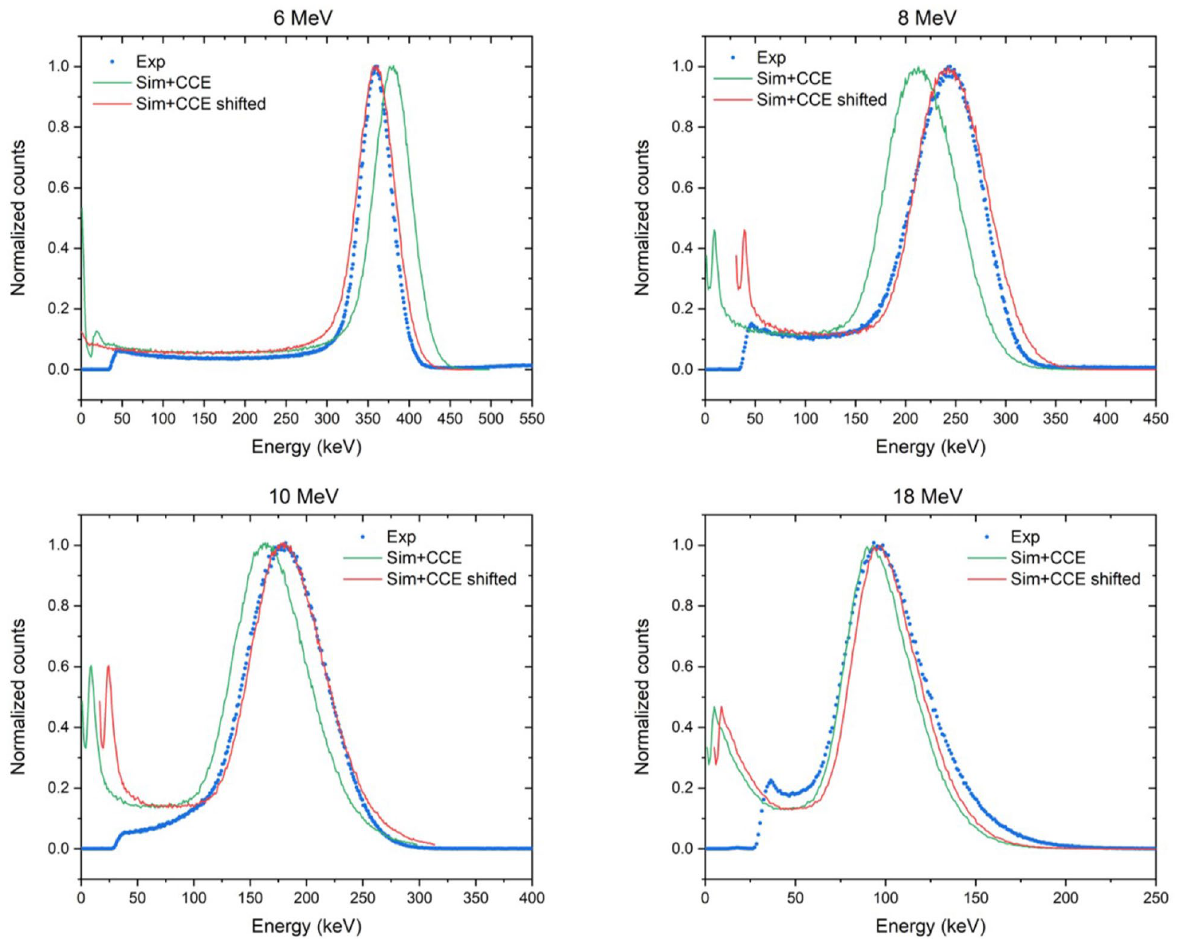
Figure 7. Experimental energy spectra (blue dots), Monte Carlo simulations of the spectra after applying the CCE correction (green solid lines), and simulated spectra when the corresponding shift offsets are applied (red solid lines) for 6, 8, 10 and 18 MeV proton